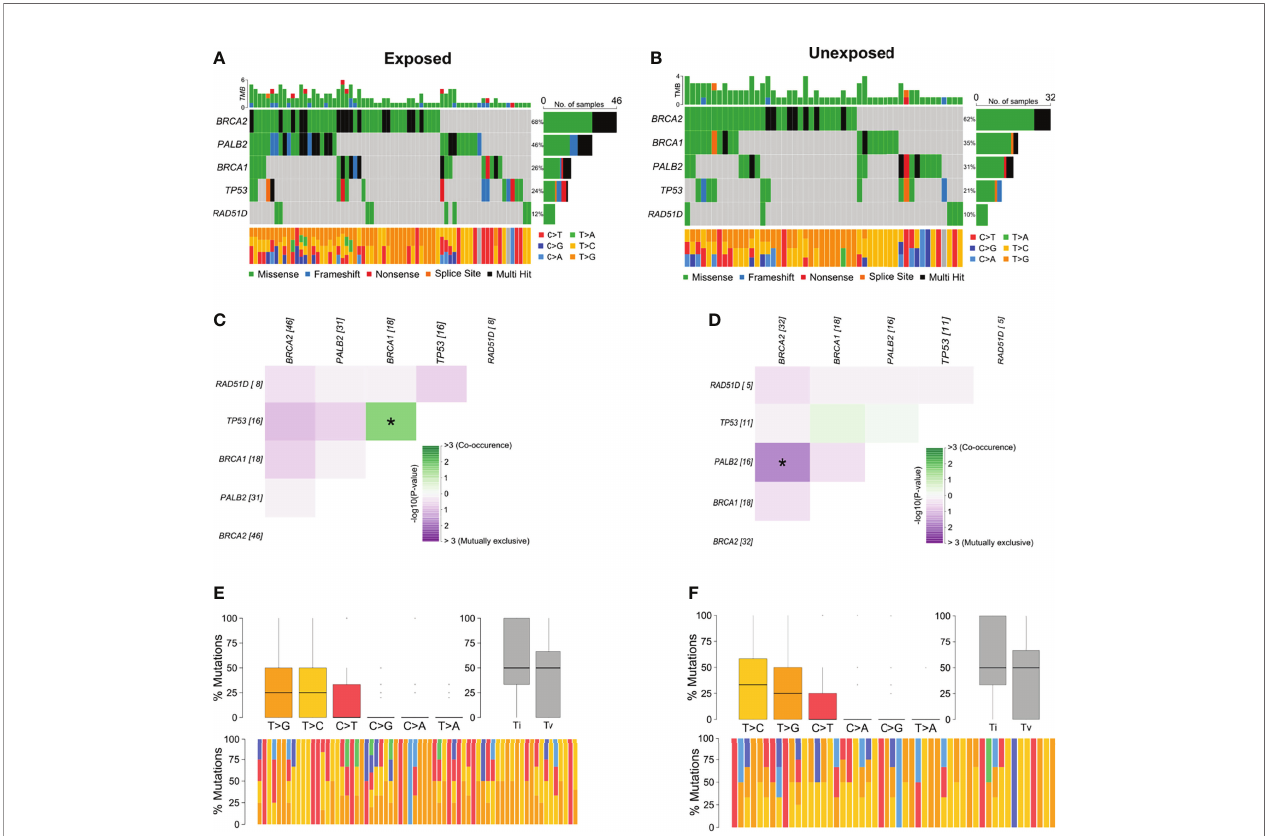
FIGURE 3 | Genomic landscapeand potential associationsbetween mutationsin tumor breast cancer samples grouped accordingto pesticide occupational exposure. (A,B) Oncoplots showing the mutational pro fi leofeach gene in groups exposedand unexposed to pesticides. (C, D) Mutational co-occurrence orexclusive associations between evaluatedgenes in (C) exposed and (D) unexposed groups. (E,F) Distribution oftransitions andtransversions in (E) exposedand (F) unexposed groups showing boxplot with overall summary of SNVs classi fi ed into six substitution classes, boxplot with distribution ofSNVs classi fi ed into transitions(Ti) and transversions(Tv), and proportion ofSNVs per sampleclassi fi edinto six substitution classes. Color legend of panels (A, B) isthe same for panels (E,F) , respectively. The symbol * means statistical signi fi cance (p <